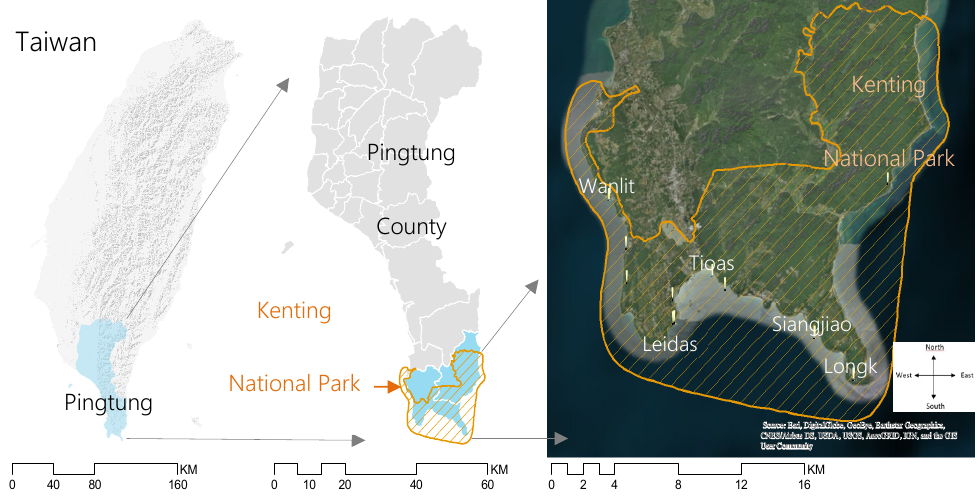
Figure 1. Research scope of reef recreational area in Kenting National Park, Taiwan.